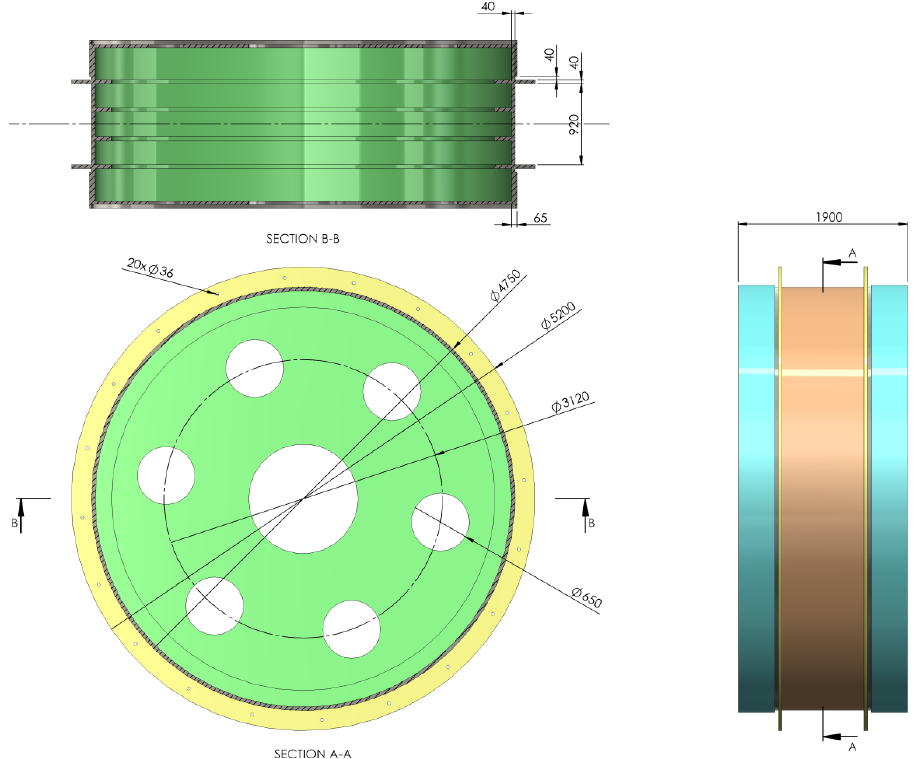
Figure 11. Drive wheel and drum-and-shoe brake system model for the MK5x2 hoist. (unit: mm)